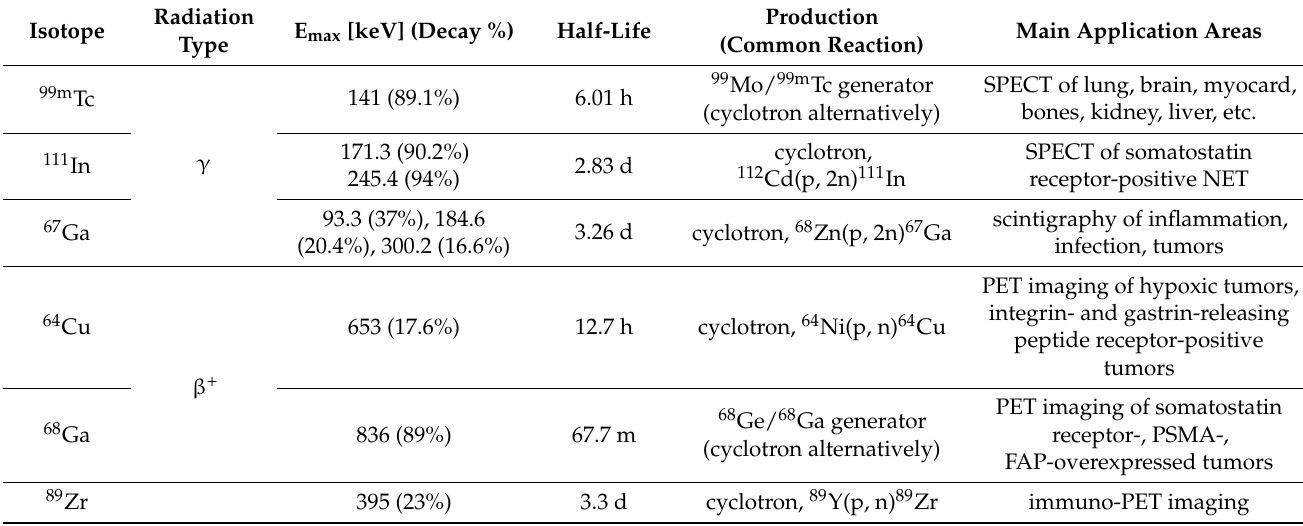
Table 1. Selected metallic radionuclides employed in diagnostic nuclear